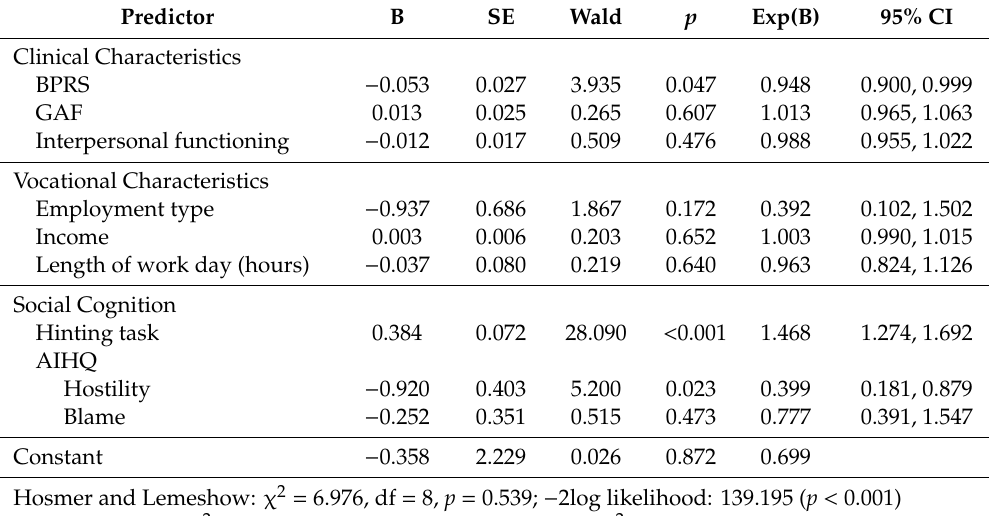
Table 5. Summary of logistic regression analyses for variables predicting job